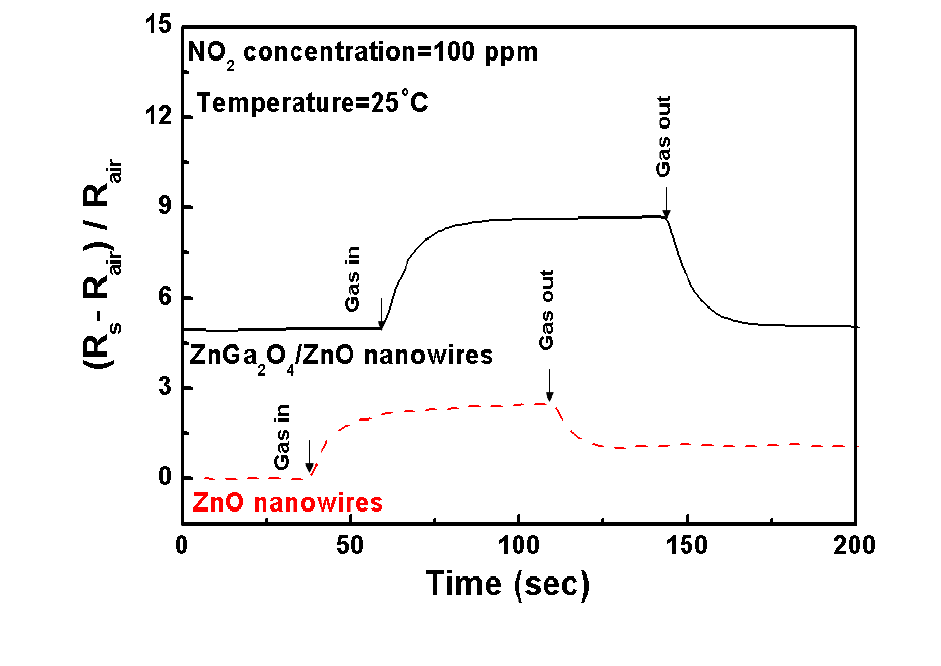
O /ZnO core shell nanowire sensor and ZnO 2 4 concentration in synthetic air at 25 2